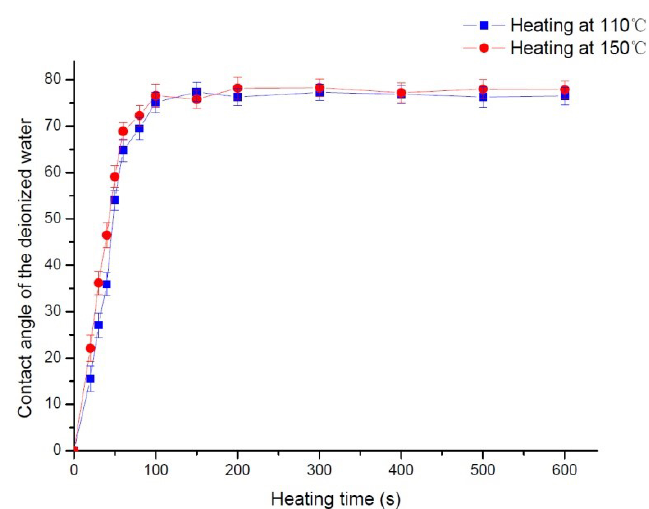
Figure 3. Influence of the heating time on the surface contact angle. By varying the heating temperature and heating time, by heating the substrate under 110 ◦ C and 150 ◦ C for 20 s, 40 s, 60 s, 80 s, 100 s, 150 s, 200 s, 300 s, 400 s, 500 s, and 600 s at each temperature, the deionized water contact angles were measured in different heating